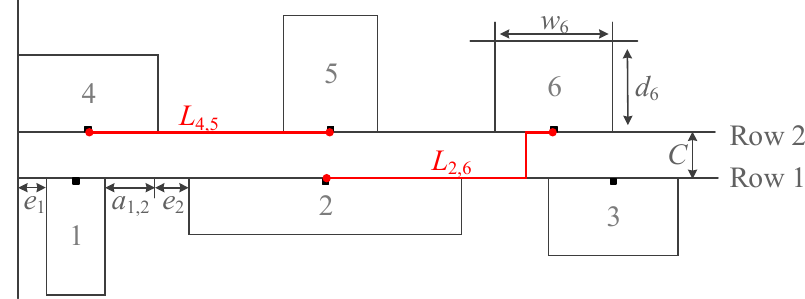
Figure 1. A layout for SR-DRLP.